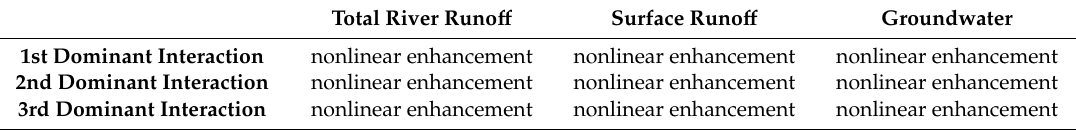
Table 8. Interaction modes of the factors on runo ff in the middle elevation terrace